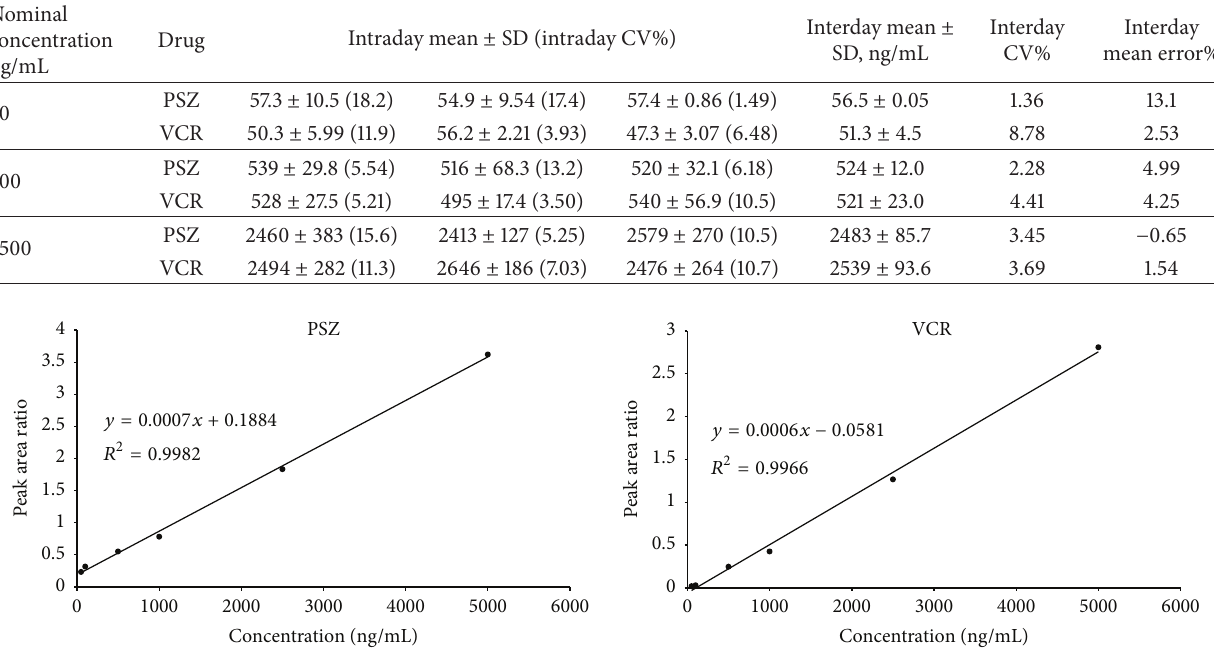
Figure 2: Linearity and regression for the determination of PSZ and VCR in rat plasma.